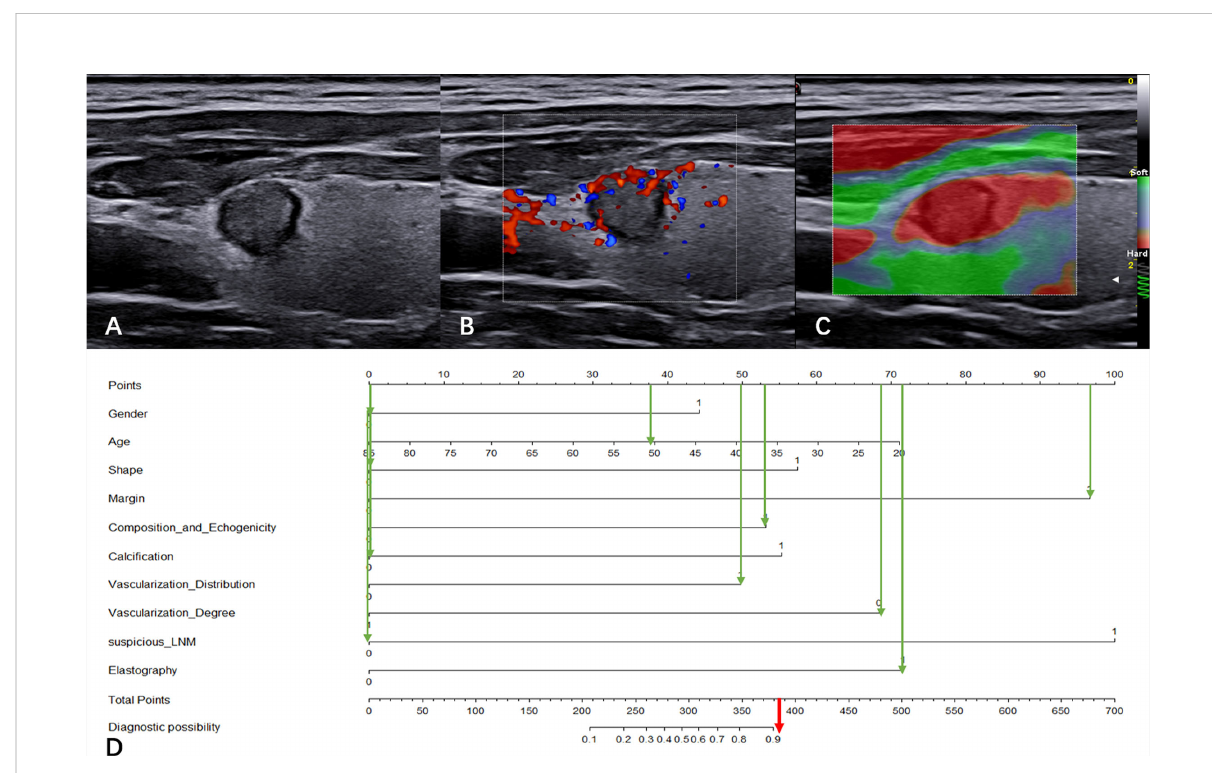
FIGURE 6 Clinical application of the CBCE nomogram. Images from a 51-year-old woman with a nodule (9.1×7.8×8.2 mm) in the left thyroid and the pathology was papillary thyroid carcinoma. (A) Greyscale ultrasound imaging of the mass. The lesion showed a wider-than-taller shape, irregular margins and solid hypoechoicity. (B) Internal vascularization distribution and low vascularization degree of the nodule in color Doppler. (C) Strain elasticity of the nodule was hard. (D) In the nomogram, the total score was 379, and the corresponding malignancy rate of the nodule was high (>0.90). The green arrows indicate the score corresponding to each risk factor, and the red arrow indicates the total score of the